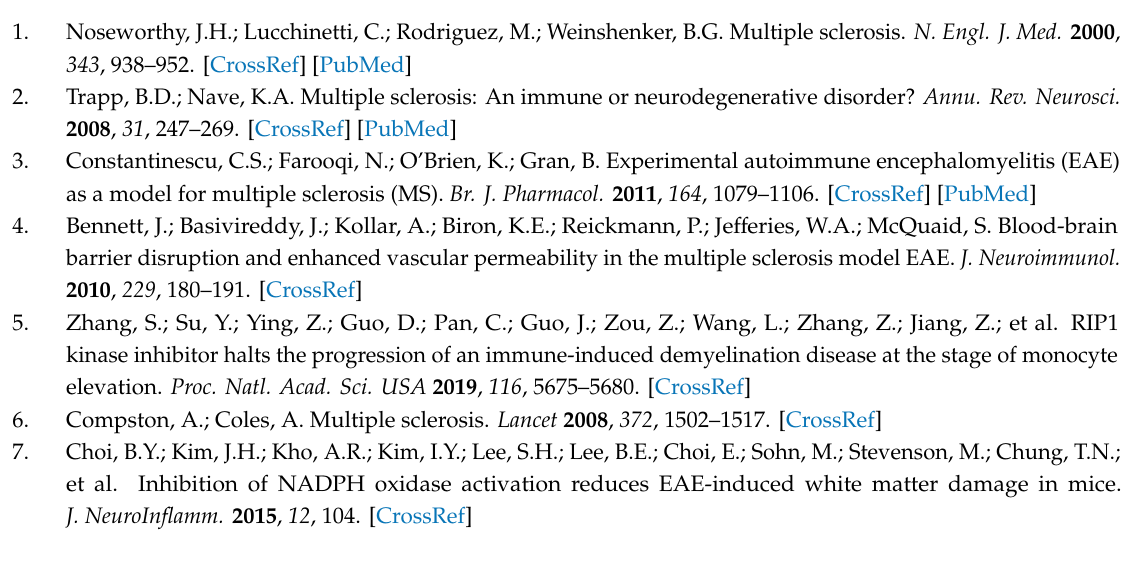
Figure S1: 1H10 treatment reduces EAE-induced astrogliosis in the white matter of spinal cord, Video S1: Behaviors of vehicle-treated control group mice, Video S2: Behaviors of 1H10-treated control group mice, Video S3: Behaviors of vehicle-treated EAE mice, Video S4: Behaviors of 1H10-treated EAE